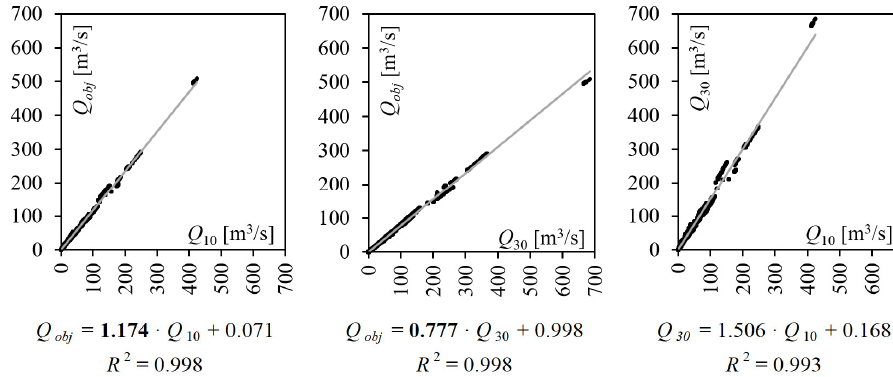
Figure 11. Linear relations between the thresholds defined by Q 10 , Q 30 , and Q obj